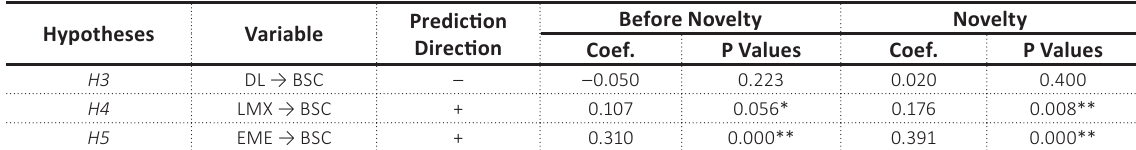
Table 8. Sensitivity test of earlier measurements compared to new measurements (Novelty) in model 2 Source: Nauman et al. (2021); SmartPLS 3 processing